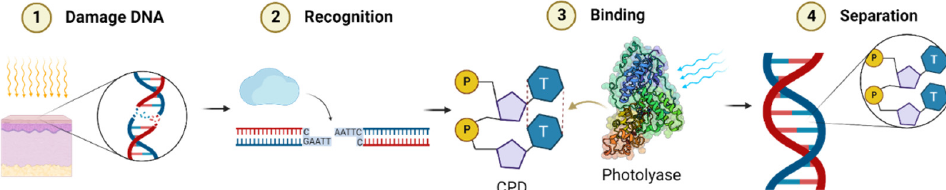
Figure 5. DNA repair by photolyase. DNA damage can be repaired by the enzyme photolyase in three steps: recognition of the damage, binding of the photolyase and the DNA damage, and